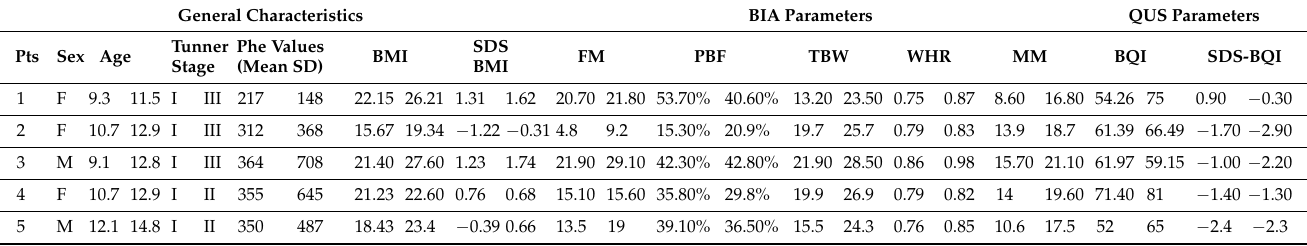
Grey columns: prepubertal period. White columns: post-pubertal period.